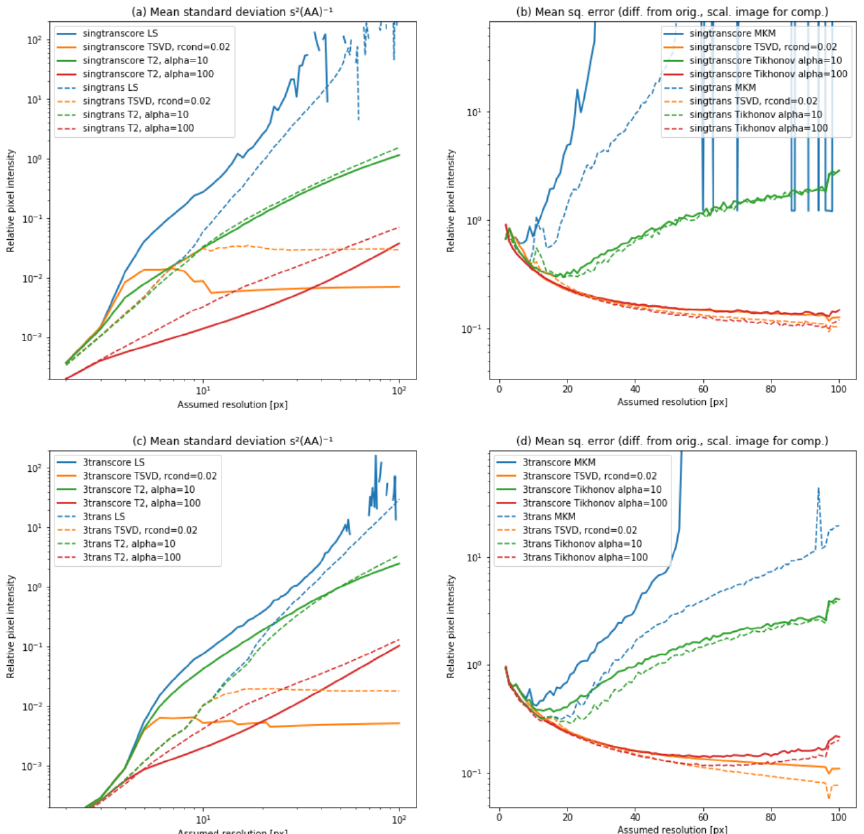
Figure 13. Comparison of regularization techniques. Mean SD of the result is shown in panels (a) and (c) . Panels (b) and (d) show the similarities between the recovered image and the true image. Both are shown relative to the mean intensity of the original image. Panels (a) and (b) show the relative SD and the similarity for the SIMO cases and the lower plots for the MIMO cases. The solid lines show recoveries when only using the core array, and the results with dashed lines include the outriggers. The line colour shows the type of regularization; blue is not regularized (ordinary least squares), orange is TSVD (including only singular values higher than 2% of the greatest singular value), and green and red lines are Tikhonov damped singular values with α = 10 and 100, respectively.